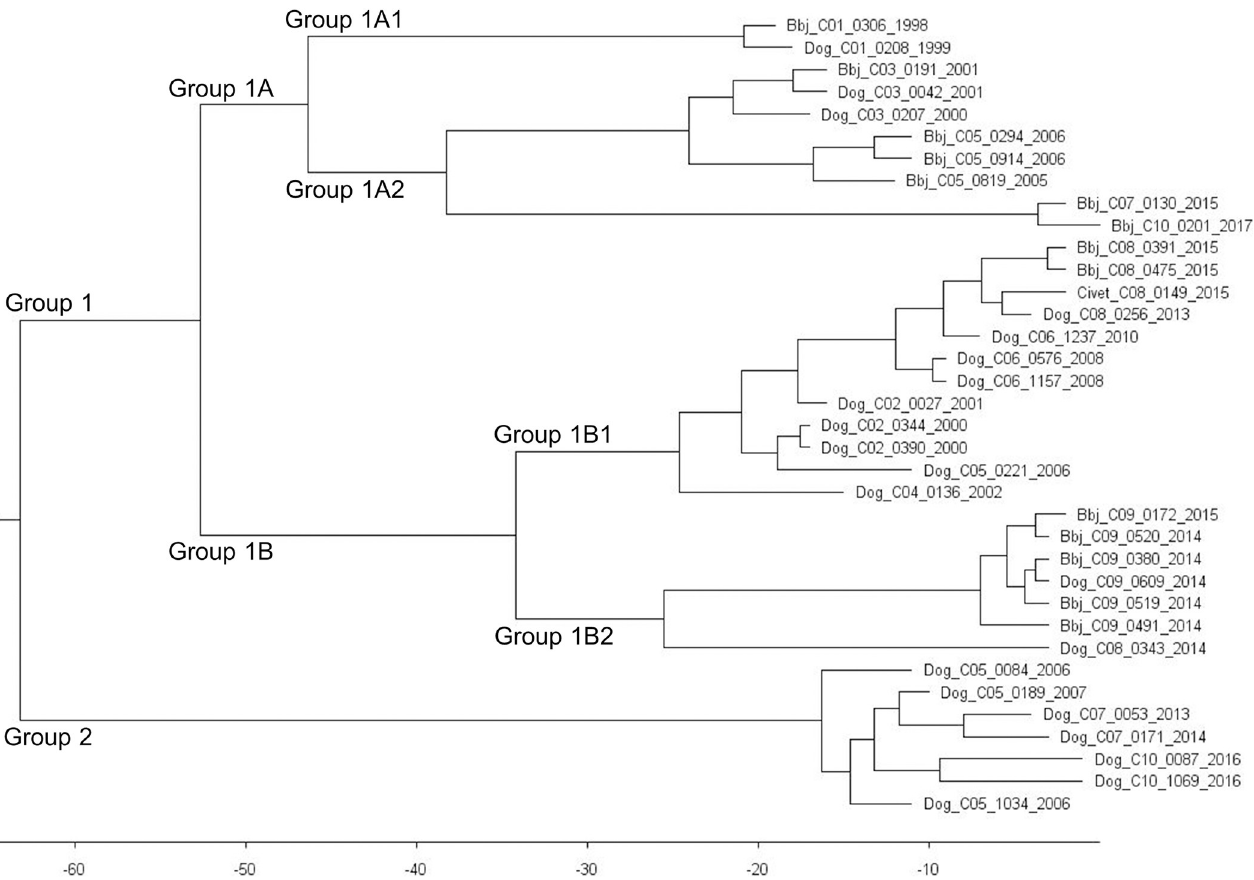
Fig 6. Phylogenetic tree of rabies viruses in dogs and wildlife in 10 spatio-temporal clusters of dog rabies between 1998 and 2017. The X-axis shows the estimated years of rabies virus evolution prior to 2017. The first block of the virus designation indicates the animal species: Dog, black-backed jackal (Bbj), or civet cat (Civet). The second block is the cluster identification, the third the virus code, followed by the year of sample